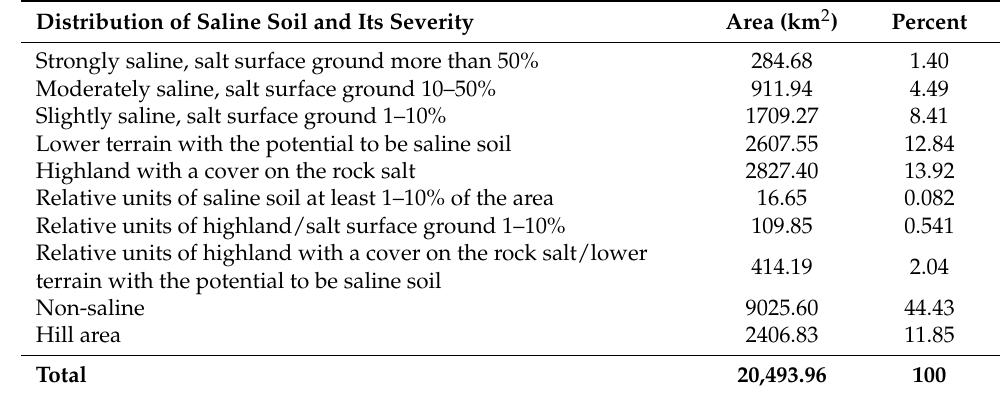
Table 1. Distribution of saline soil and its severity in Nakhon Ratchasima province [14]. Distribution of Saline Soil and Its